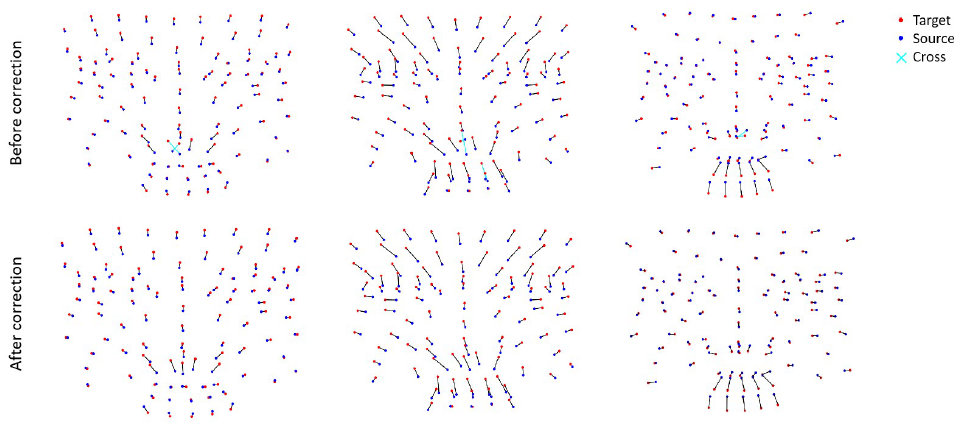
Figure 10. Cases for additional correction.